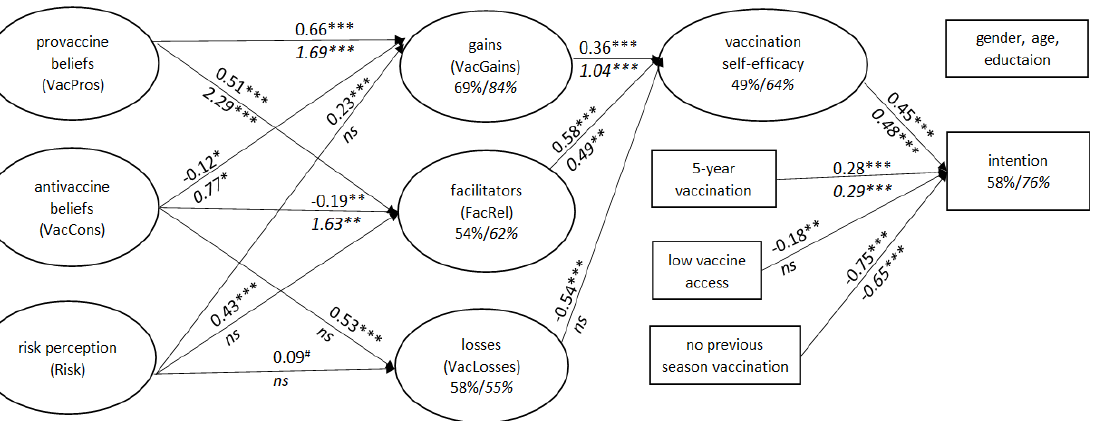
Figure 2. The result of SEM in medics ( n = 301; path coefficients in italics below the arrows) and non-medics ( n = 408; path coefficients in regular font above the arrows) analyzed for each group separately (showed in one figure for better visualization). Note: *** = p < 0.001; ** = p < 0.01; * = p < 0.05; # = p = 0.05; ns = not